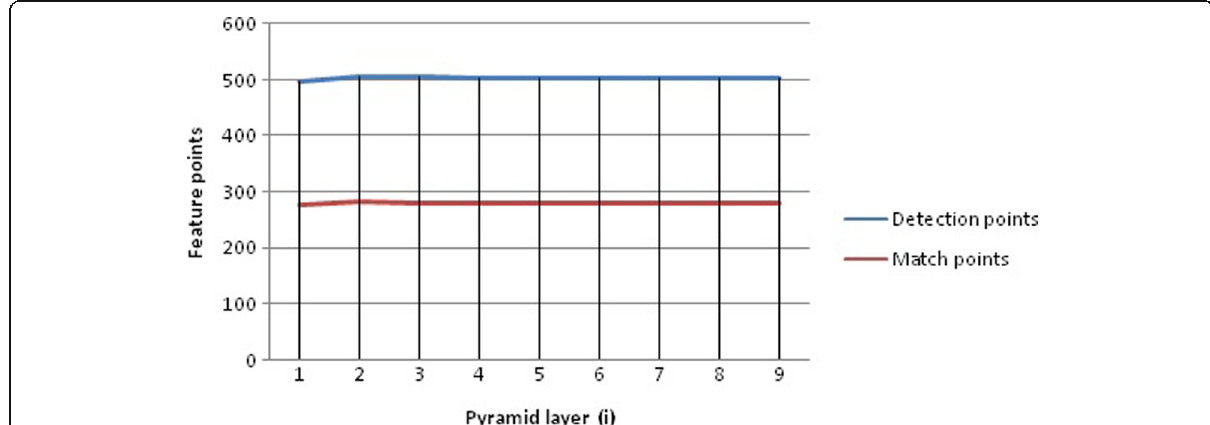
Fig. 10 Feature point detection number and exact matching number comparison chart when the scale parameter between pyramid images changes